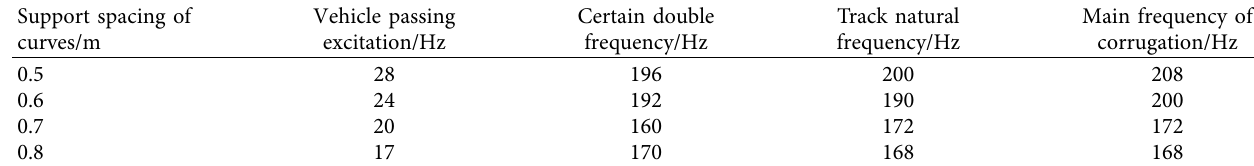
Figure 7: Natural vibration modal analysis of the wheel-rail system. (a) Typical modes of curved track with 200m radius. (b) Typical modes of curved track with 300m radius. (c) Typical modes of curved track with 400m radius. (d) Typical modes of curved track with 1000m radius. Table 2: Frequency domain characteristics of corrugation of different